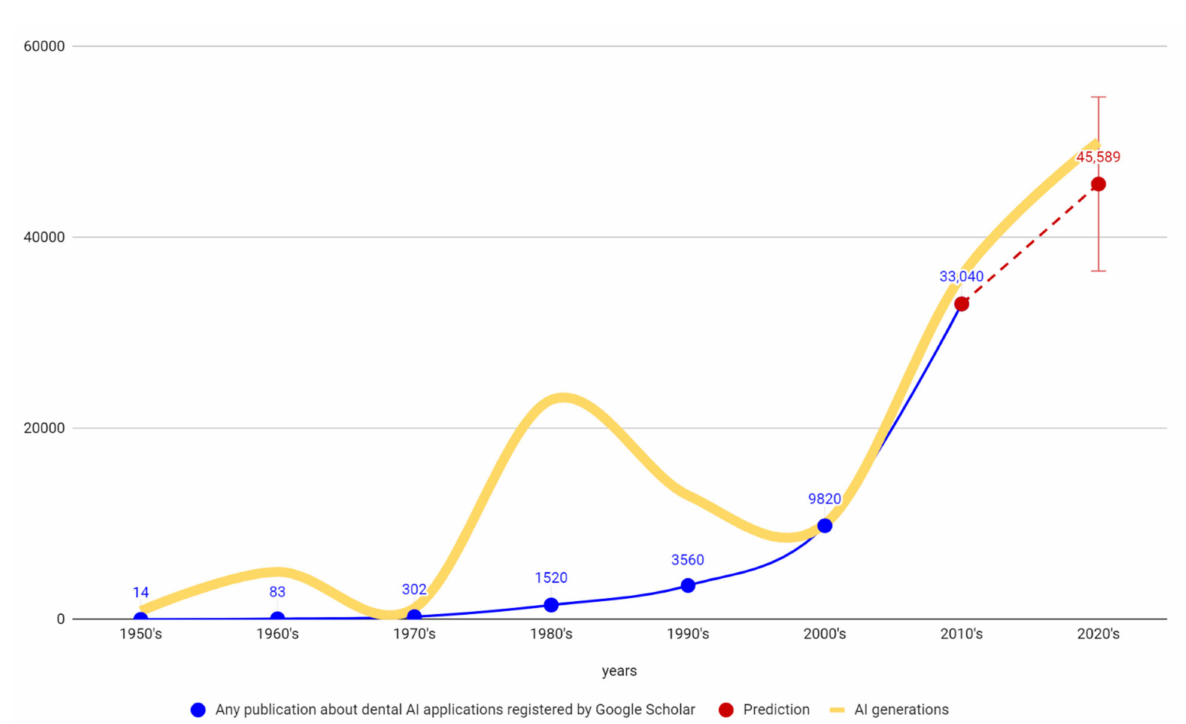
Figure 1. Visualization of 1st, 2nd and current 3rd waves of AI generations (booms) in human history does not correspond to the history of Google Scholar dental-AI publications, thus indicating that only the current 3rd AI generation is mature enough to offer undisputed potential for research and application in dentistry. Visualized prediction for the next decade of dental AI publications was calculated by simple extrapolation using a linear regression, and is just for